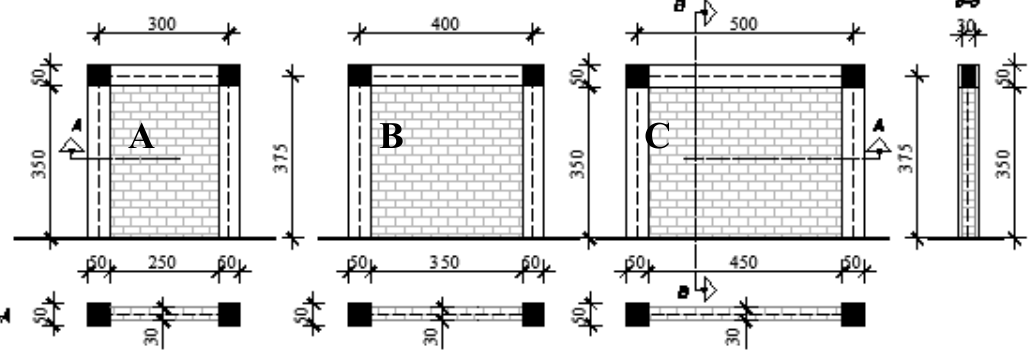
Figure 3. Infilled frame models.